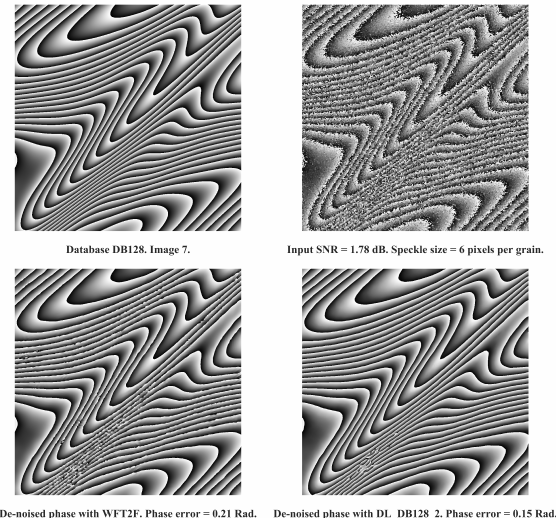
Figure 4. Trends of metrics vs input cosine SNR for 4 selected algorithms. From top to bottom : phase error, Qindex and PSNR.